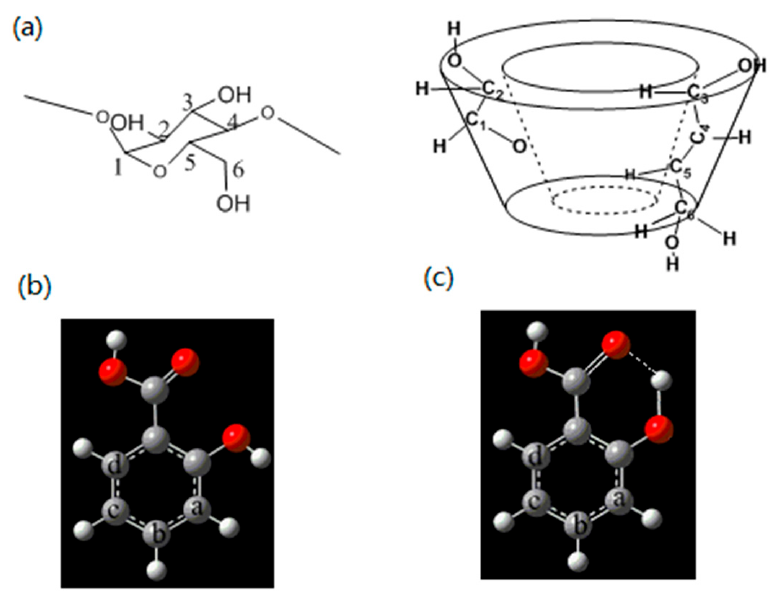
Figure 1. ( a ) Molecular structures of β -CD, with glucose unit connected via bonds 1–4; ( b , c ) molecular structures of SA.